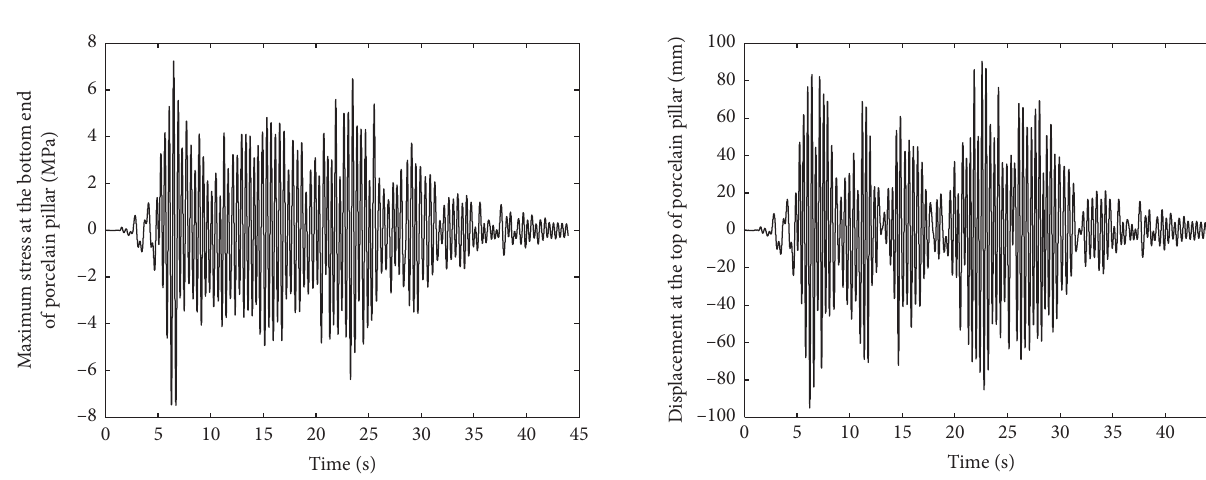
Figure 24: Displacement at the top of porcelain pillar ( a � 0.5g, η � 20,000).